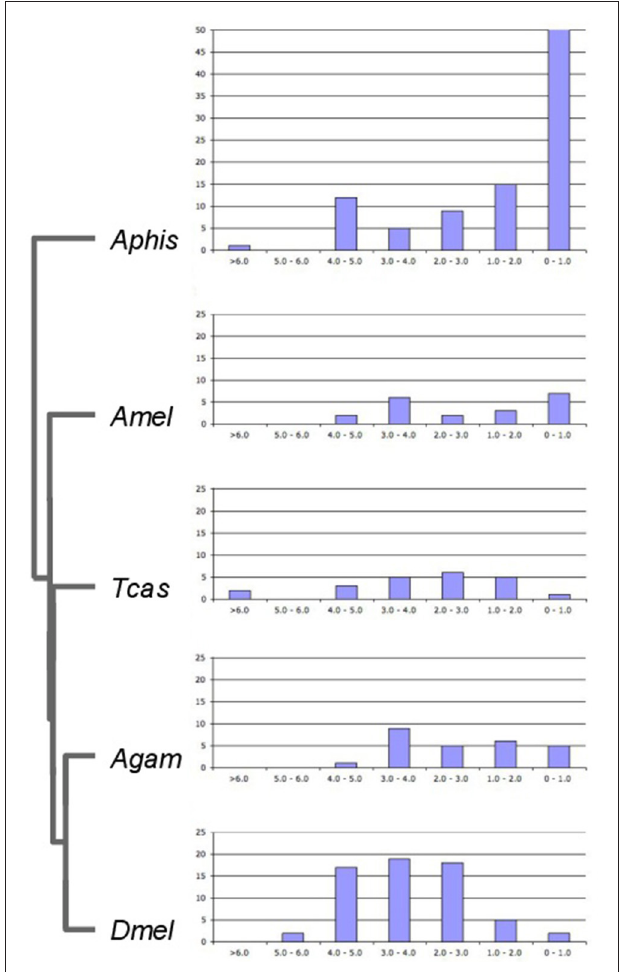
FIGURE 3 | Age distribution of lineage-specific gene duplicates. Bar graphs show numbers of lineage-specific paralog pairs (Y-axis) binned by their dS distances as an estimate of gene duplicate ages (X-axis). Species name abbreviations same as in Figure 1